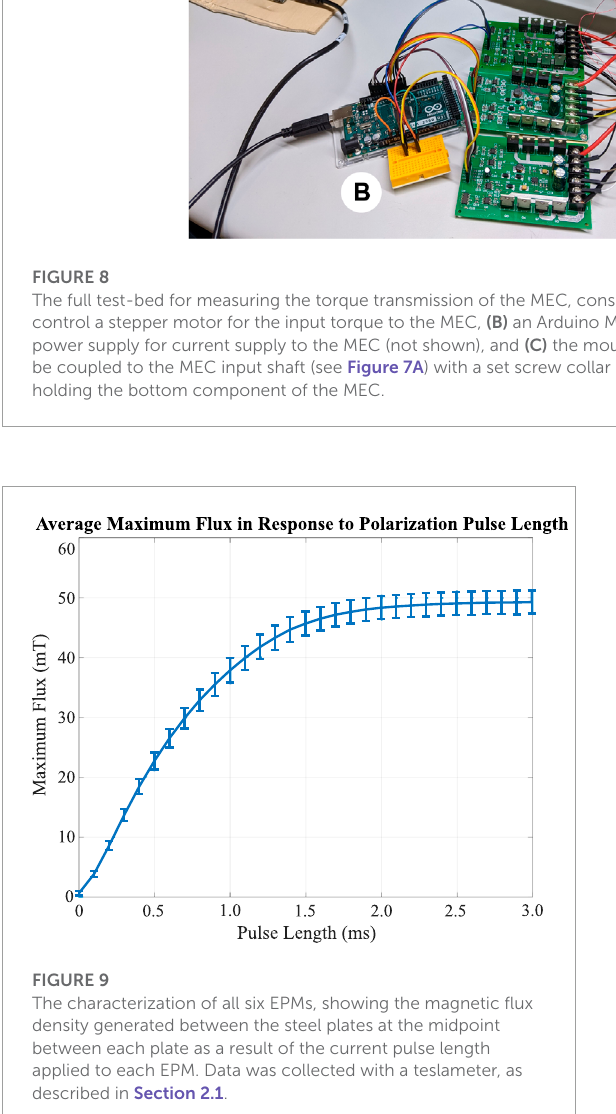
8 kA/m). With this value of H field, we anticipate the design to be field).